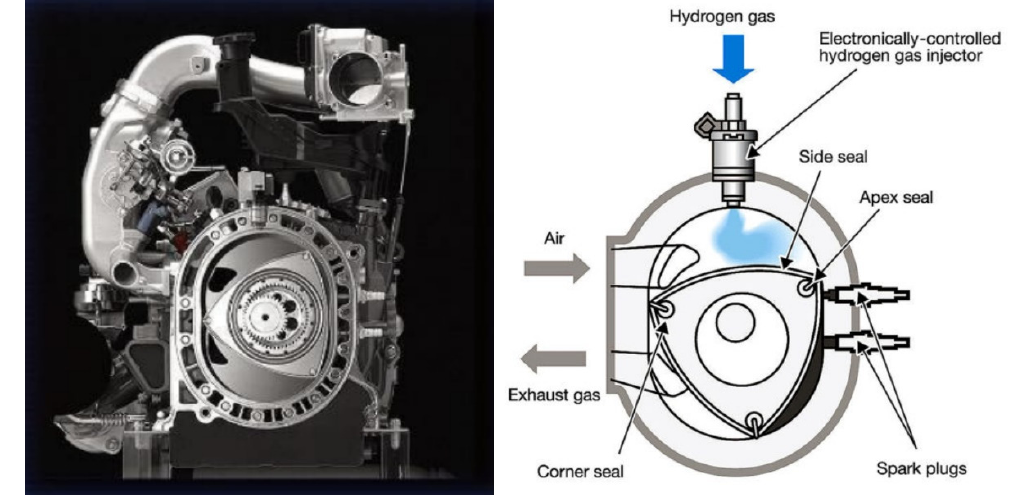
Figure 2. Cross-sectional diagrams of the hydrogen Wankel rotary engine [58].